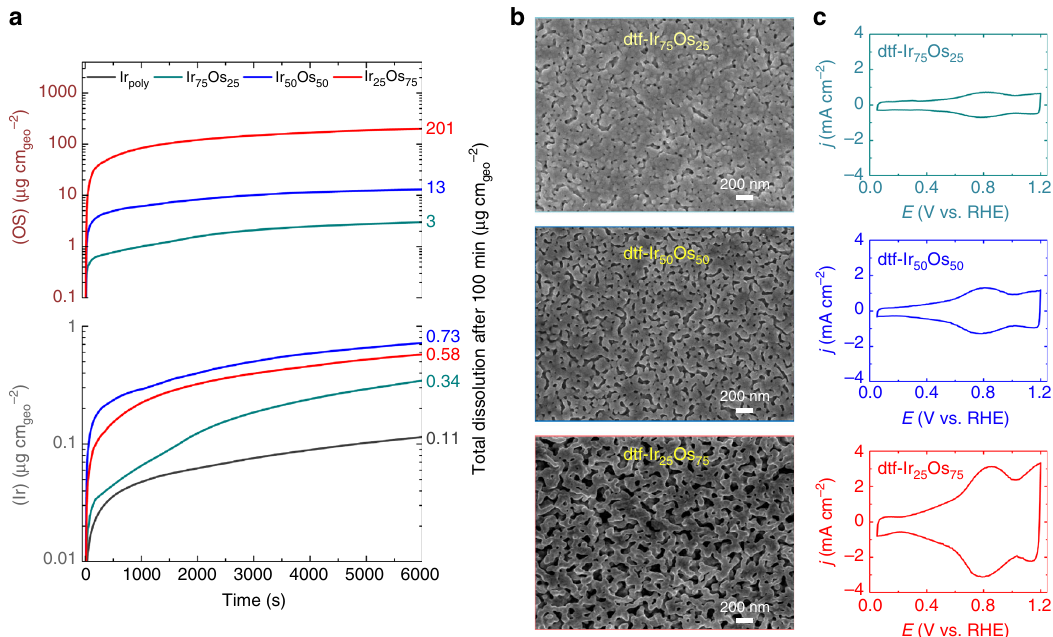
Fig. 1 In situ dealloying dynamics of Ir x Os (1 − x ) alloys. a Comparison between total Os (top curves) and Ir (bottom curves) dissolution measured in situ with SPRDE-ICP-MS for Ir 75 Os 25 (green), Ir 50 Os 50 (blue) and Ir 25 Os 75 (red) and Ir-poly (black) under the same conditions (1 mA cm − 2 in 0.1 M HClO 4 at 25 °C) demonstrating signi fi cant dissolution of Os, accompanied by a small Ir loss during the dealloying protocol. b Representative SEM images of dealloyed Ir x Os (1 − x ) catalysts revealing a porous architecture, with varying pore size (10 – 100 nm) and surface-to-volume ratio generated through the dealloying process. c Corresponding cyclic voltammograms (CVs) of dealloyed materials (0.1 M HClO 4 at 50 mV s − 1 ), showing the same pseudocapacitive (OH ad ) pro fi les and peak position but with increasing current density for higher Os contents in the alloy, indicative of higher ECSA and negligible electronic effect of Os content in the